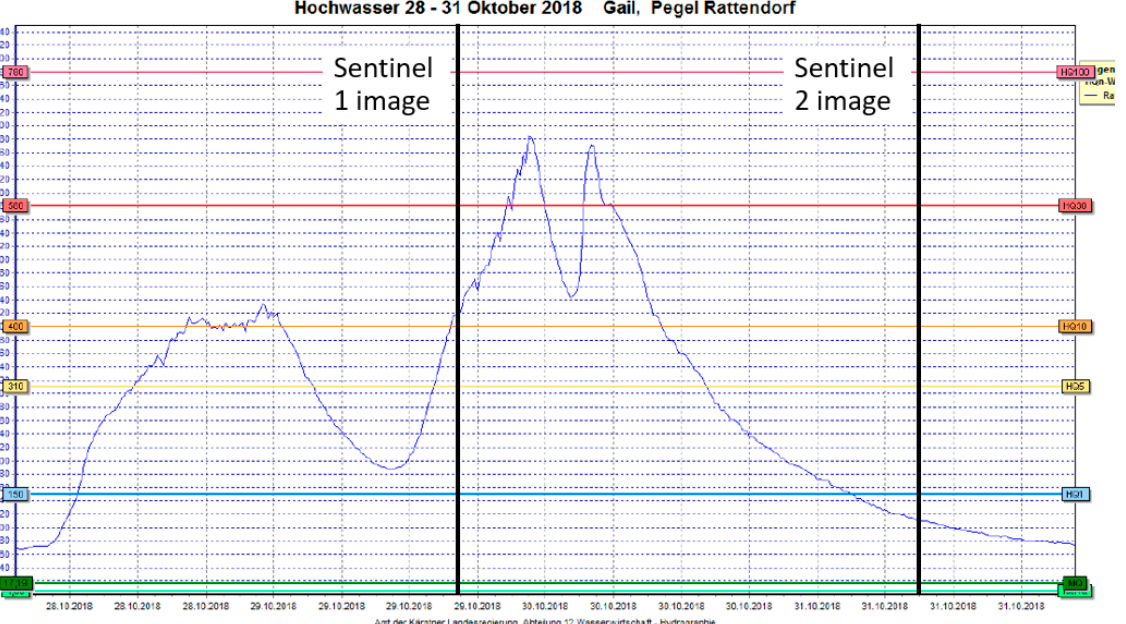
Figure 9. The water level at the Rattendorf hydrological station on river Gail from 28–31 October 2018. Black lines show the times of Sentinel-1 and Sentinel-2 image acquisition. Source of original image: [31].